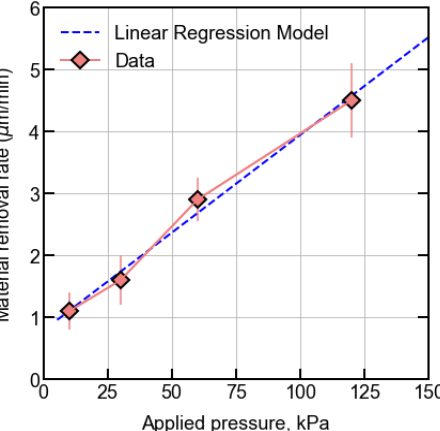
Figure 5. Evolution of material removal rate versus applied pressure during the lapping step.